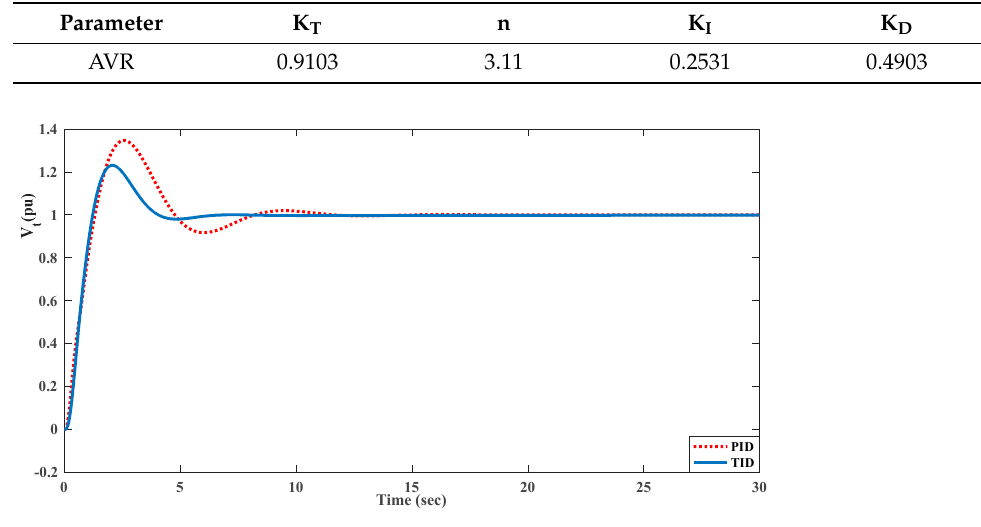
Figure 18. System dynamics of AVR, Δ V t1 . Table 12. Optimized PID controller parameters for AVR. Table 14. Comparative dynamic measures with PID and TID